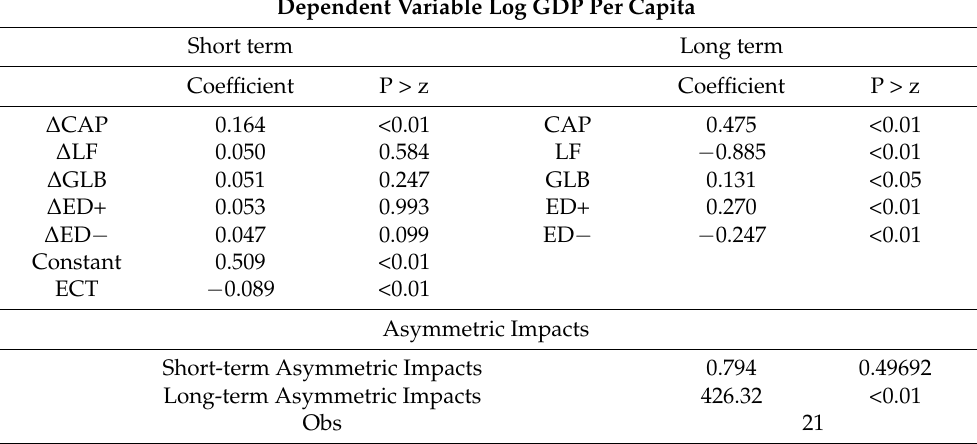
Table 5. Results of the NPARDL